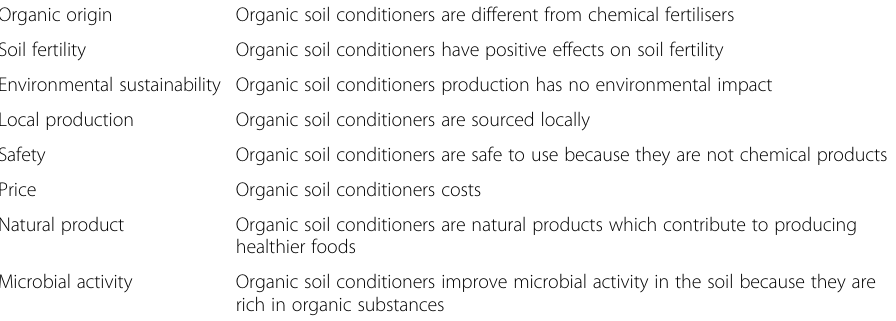
Table 1 Organic soil conditioners ’ attributes Organic origin Organic soil conditioners are different from chemical fertilisers Soil fertility Organic soil conditioners have positive effects on soil fertility Environmental sustainability Organic soil conditioners production has no environmental impact Local